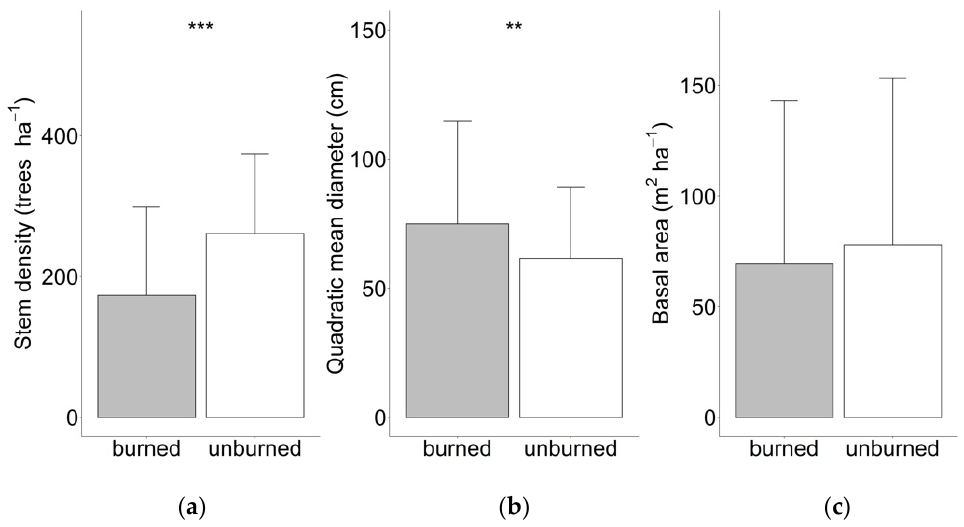
Figure 2. Differences in plot-level stem density ( a ), QMD ( b ), and basal area ( c ) for burned and unburned plots. Bar height represents average values +1 standard deviation (bootstrapped Welch two sample t -tests: ** p < 0.01, *** p <